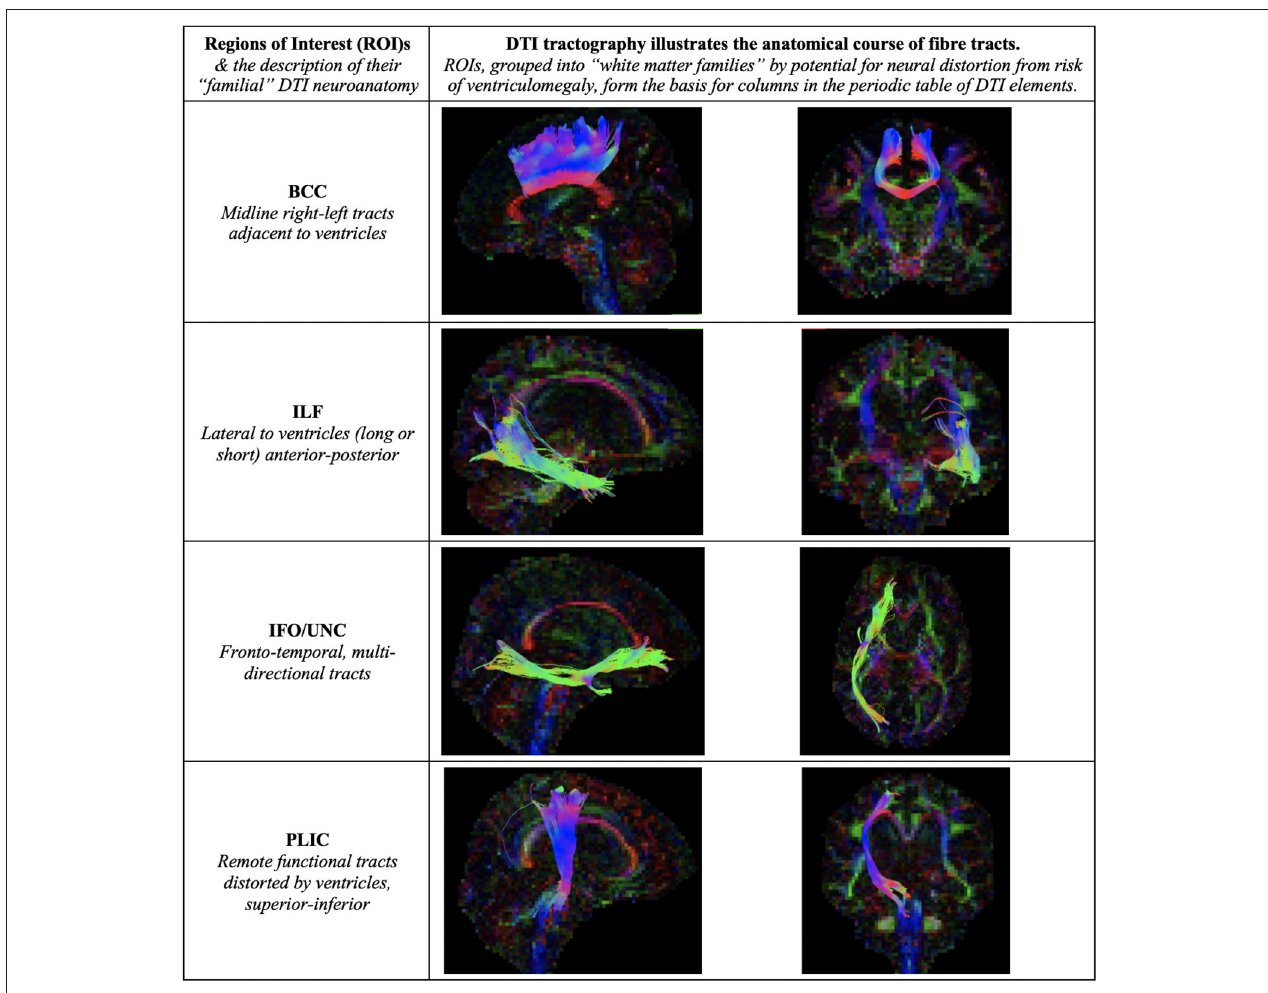
FIGURE 7 | Illustration of Regions of Interest (ROIs). We grouped ROIs into “white matter families” by their predicted potential for neural distortion due to risk of ventriculomegaly. The familial nature of these white matter tracts can be seen in the common anatomical arrangements of their fibers, e.g., right-left or superior-inferior in direction. When grouped in this way, rather than by functional considerations, we demonstrate how tractal families share diffusivity properties. This is the basis for columns in the periodic table of DTI elements. BCC, body of the corpus callosum; ILF, inferior longitudinal fasciculus; IFO/UNC, combination ROI of the inferior fronto-occipital/ uncinate fasciculi; PLIC, posterior limb of internal